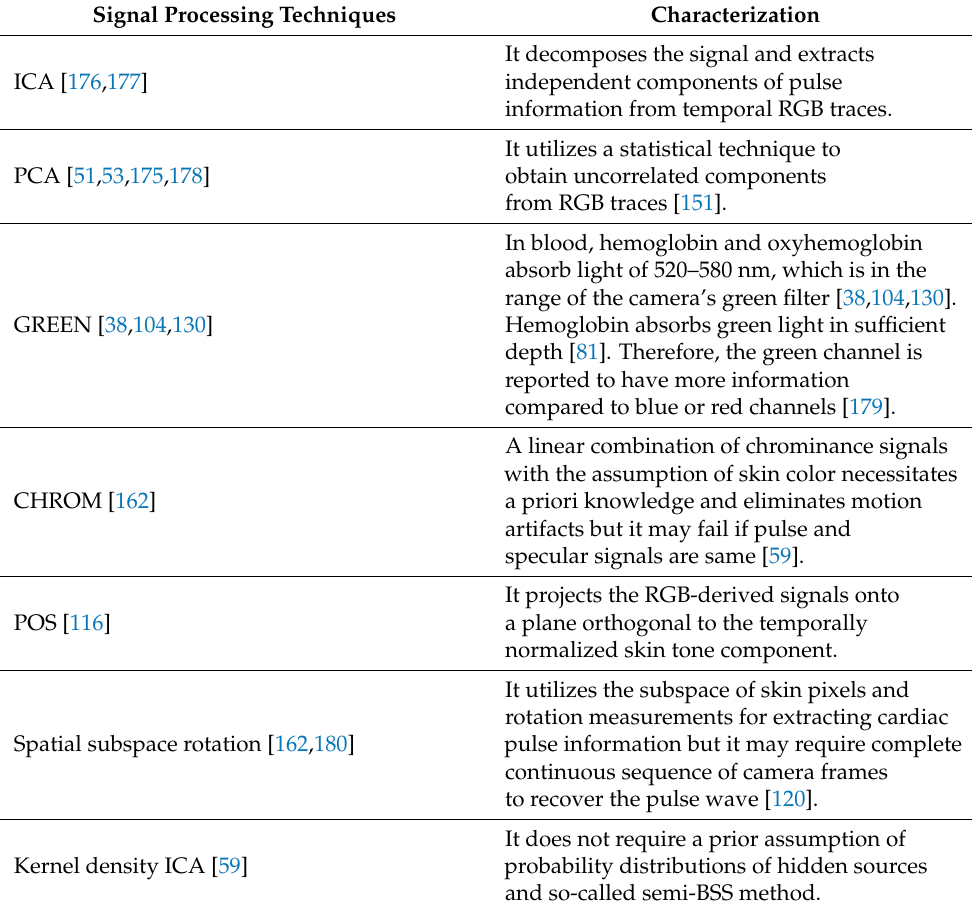
Table 5. Various algorithms for HR